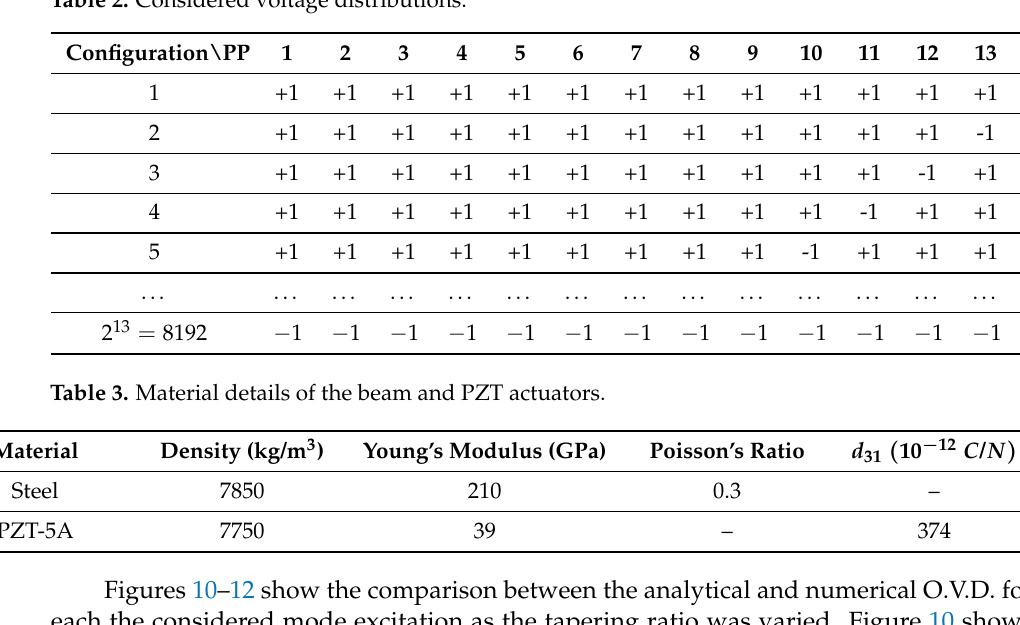
Table 2. Considered voltage distributions.